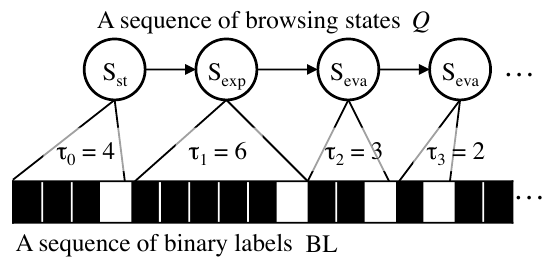
Figure 4 . Segments of browsing